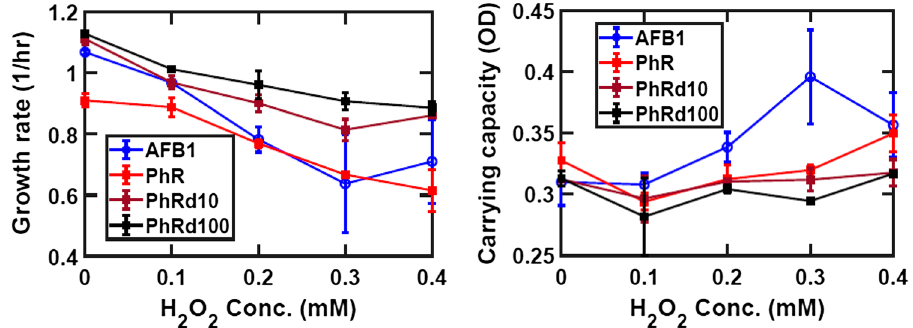
Figure 6. The blue line represents samples grown with 0.14 mM AFB 1 ; the red line represents samples grown with 0.055 mM PhR, the maroon and black lines represent respectively tenfold and one 100-fold dilutions of the initial PhR concentration. Mean values are marked as circles, error bars are standard deviations calculated for the three experimental replicates under consideration.